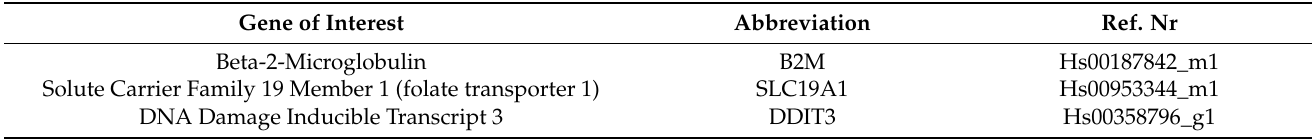
Table 2. TaqMan probes of selected genes obtained from ThermoFisherScientific (Reinach,